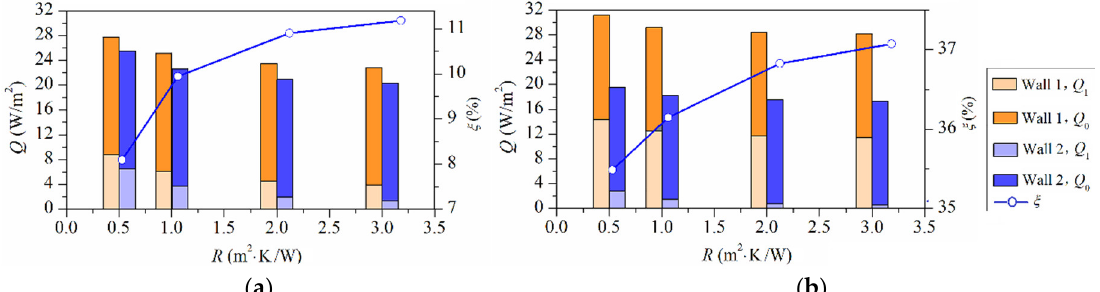
Figure 14. Comparison of the energy consumption for different insulation form with respect to different insulation resistance; ( a ) in cooling season; ( b ) in heating season.